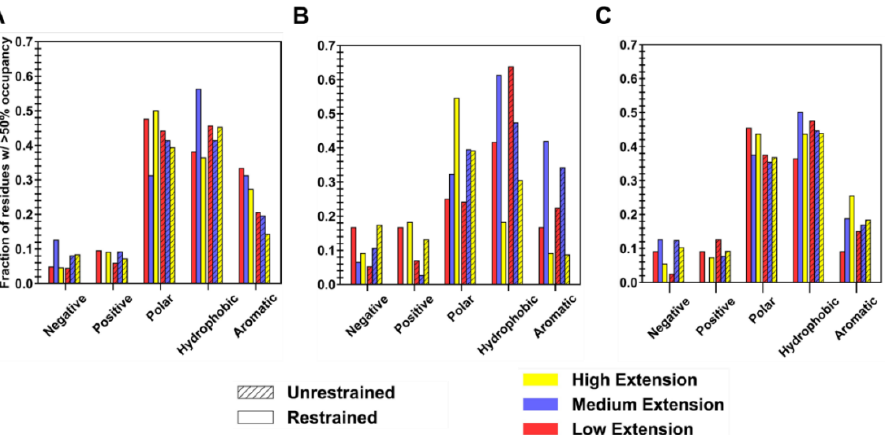
Figure 7. Fraction of residues, constituting the averaged collapsed interface (n = 7) from both the restraint-ON and -OFF phase, with occupancy values greater than 50% at different levels of oligomer extension for ( A ) PLGA/ID2S ( B ) PEG/ID2S, and ( C ) PLGA-PEG/ID2S systems. Amino acids were grouped into 5 respective categories: negative, positive, polar, hydrophobic, and aromatic, where aromatic residues were also counted in the hydrophobic group.